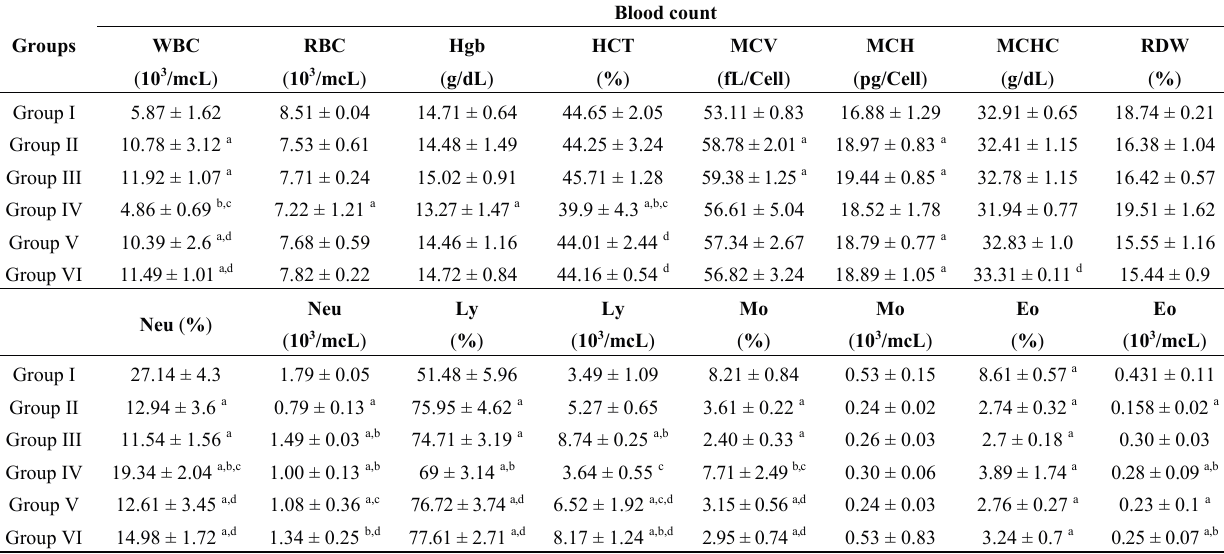
Table 7. Complete blood count parameters